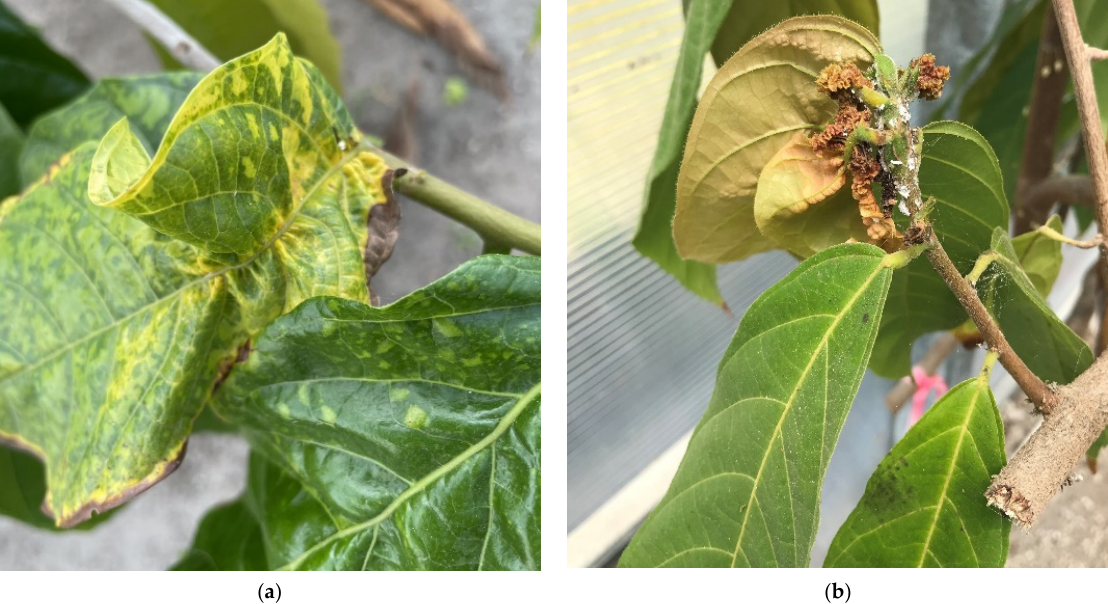
Figure 1. Signs of virus infection and mealybug infestation on Theobroma cacao : ( a ) leaves with mosaic symptoms characteristic of cacao mild mosaic virus and mild distortion caused by Maconellicoccus hirsutus , and ( b ) severe bunchy top caused by M. hirsutus .